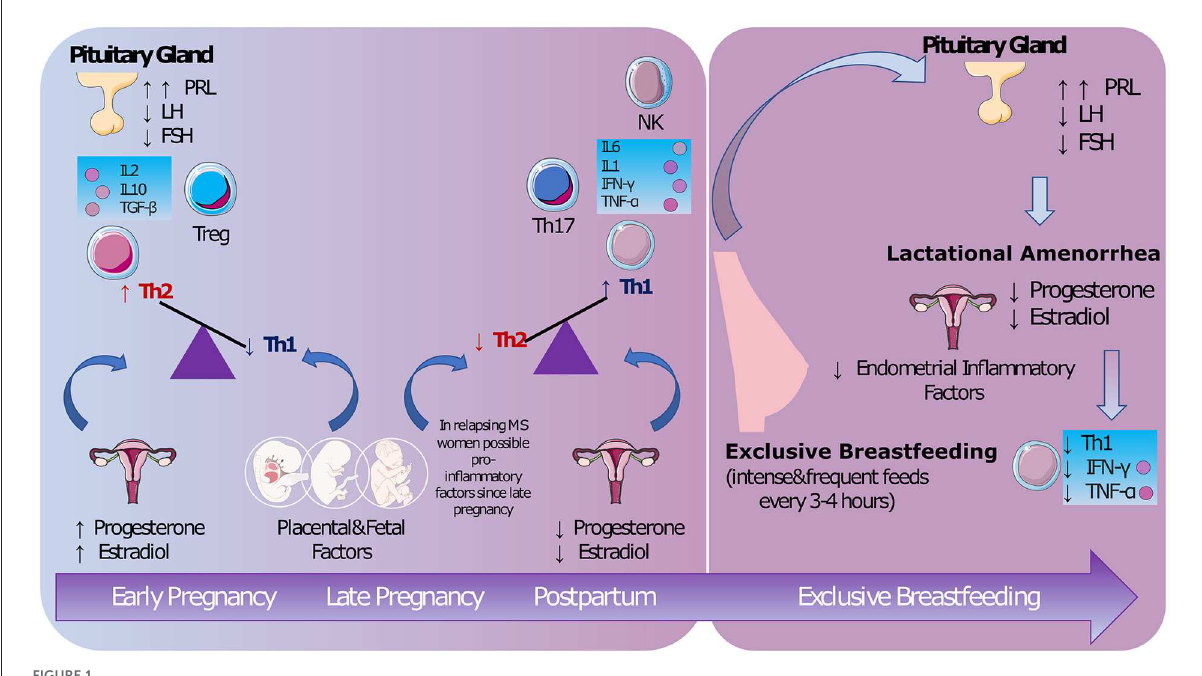
FIGURE1 The biological mechanisms. During pregnancy both hormonal and fetal/placental factors maintain a non-inflammatory status. A pro-inflammatory response is restored after delivery [possibly from late pregnancy (5)]. Lactational amenorrhea promoted by exclusive breastfeeding seems to decrease lymphocyte Th1 activity (9). PRL, prolactin; LH, luteinizing hormone; FSH, follicle-stimulating hormone; IL, interleukin; TGF, transforming growth factor; Treg, regulatory T cells; Th, lymphocyte T-helper; NK, natural killer; IFN, interferon; TNF,